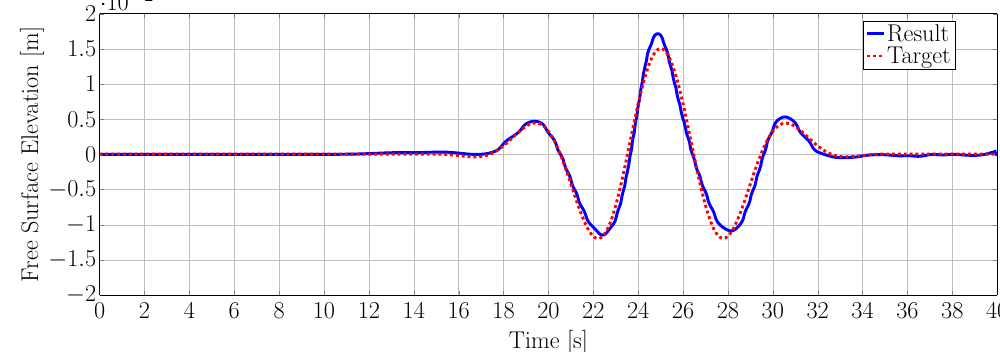
Figure 12. Target and resulting surface elevation time traces after nine calibration iterations, for the shallow water experiments. Source length 0.5 λ .